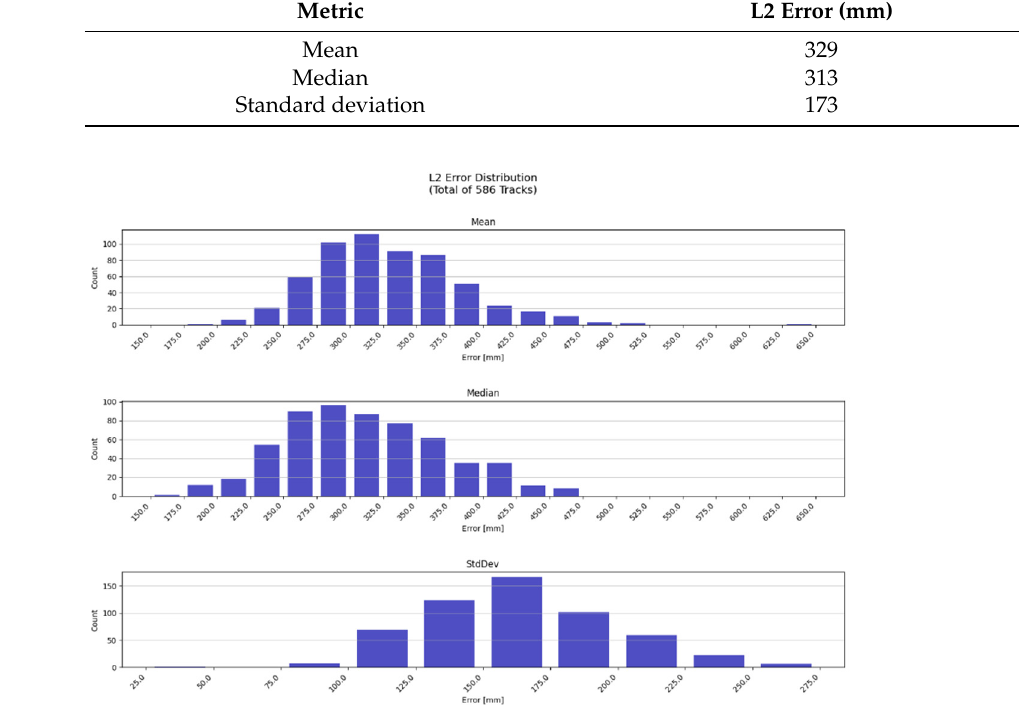
Table 7. Results of INSTEAD, MIC and EXTRAS communication.